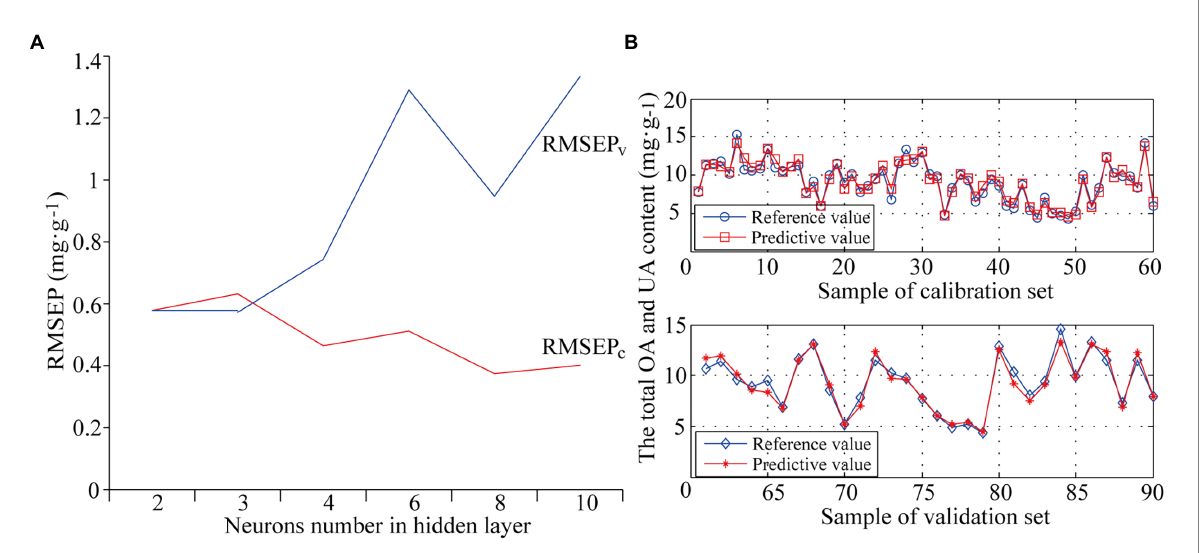
FIGURE 4 The optimization of neurons number in hidden layer (A) and prediction results of internal across validation and external validation of model M11 (B) .